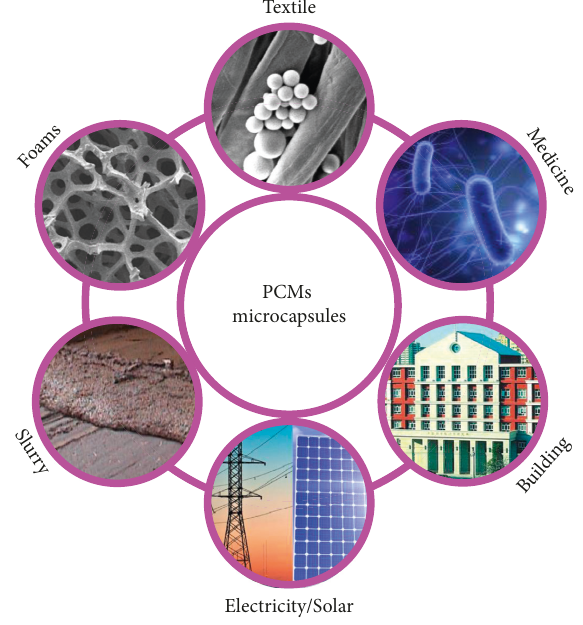
Figure 7: Potential applications of PCMs microcapsules in textile, slurry, building, foams, solar/electrical-to-energy, and